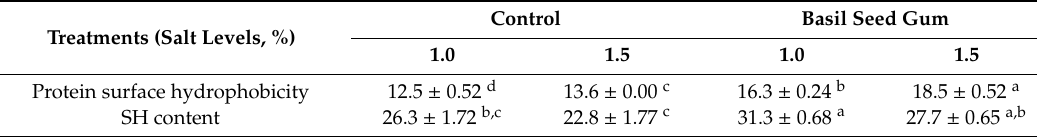
Table 8. Protein surface hydrophobicity and SH contents of low-fat sausages with basil seed gum at di ff erent salt